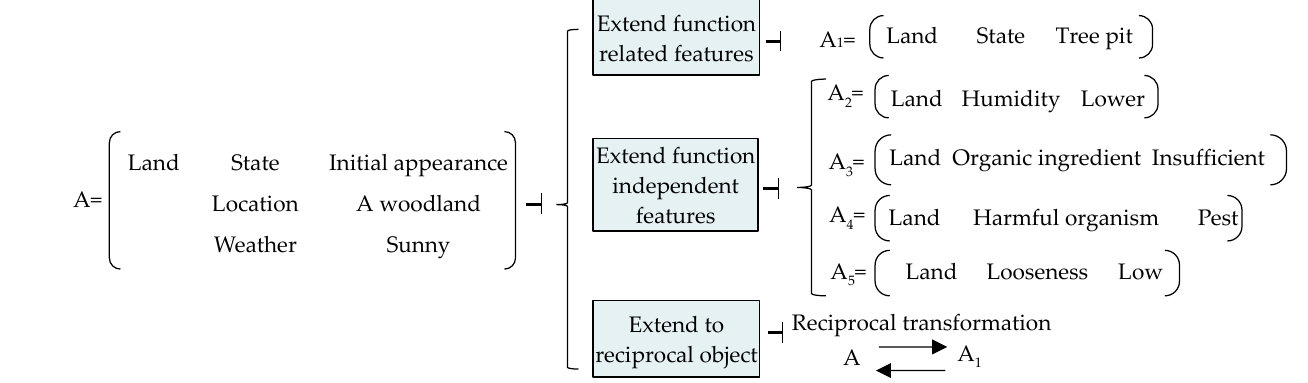
Figure 19. Extension of the extension model of the land.